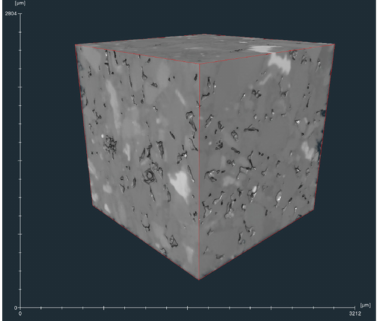
Figure 1. Micro-CT scan of Vedder sandstone sample.